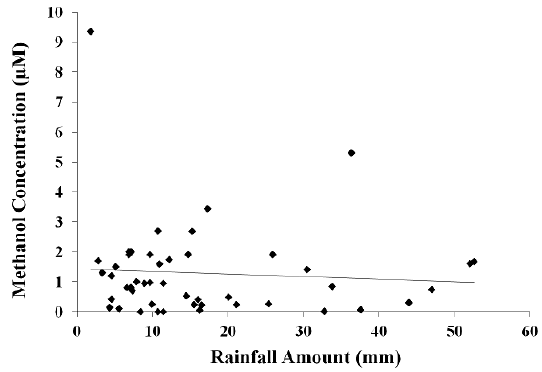
Figure 5. Methanol concentration vs. rainfall amount for all rain